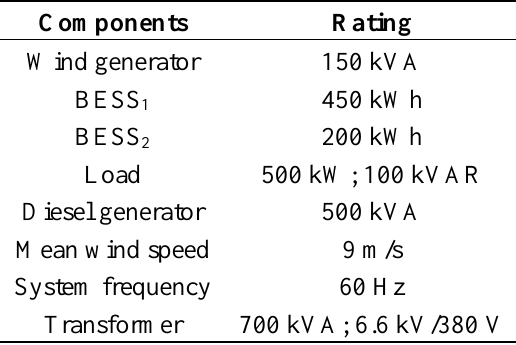
Figure 4. Configuration of microgrid. Table 2. Parameters of test microgrid.